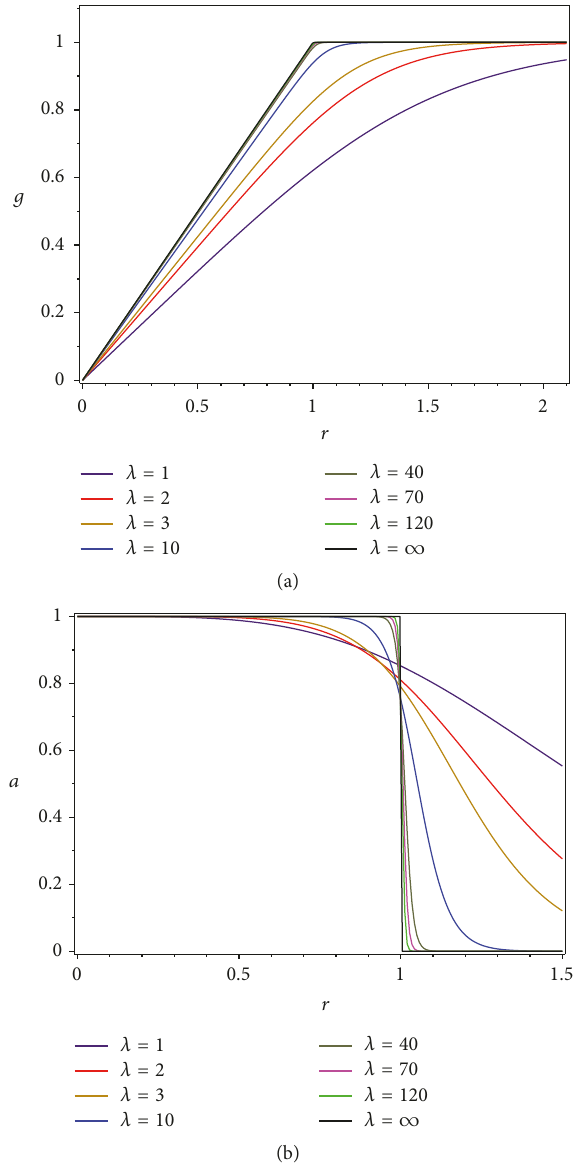
Figure 5: The profiles 𝑔(𝑟) (a) and 𝑎(𝑟) (b) come from the generalized Chern-Simons-Higgs model (69) with 𝜔(𝑔) = 𝜆𝑔 2𝜆−2 . Observe that 𝜆 = 1 (indigo lines) represents the usual CSH model and the true compacton solution is given by 𝜆 = ∞ (vertical black lines representing the 𝛿 -Dirac